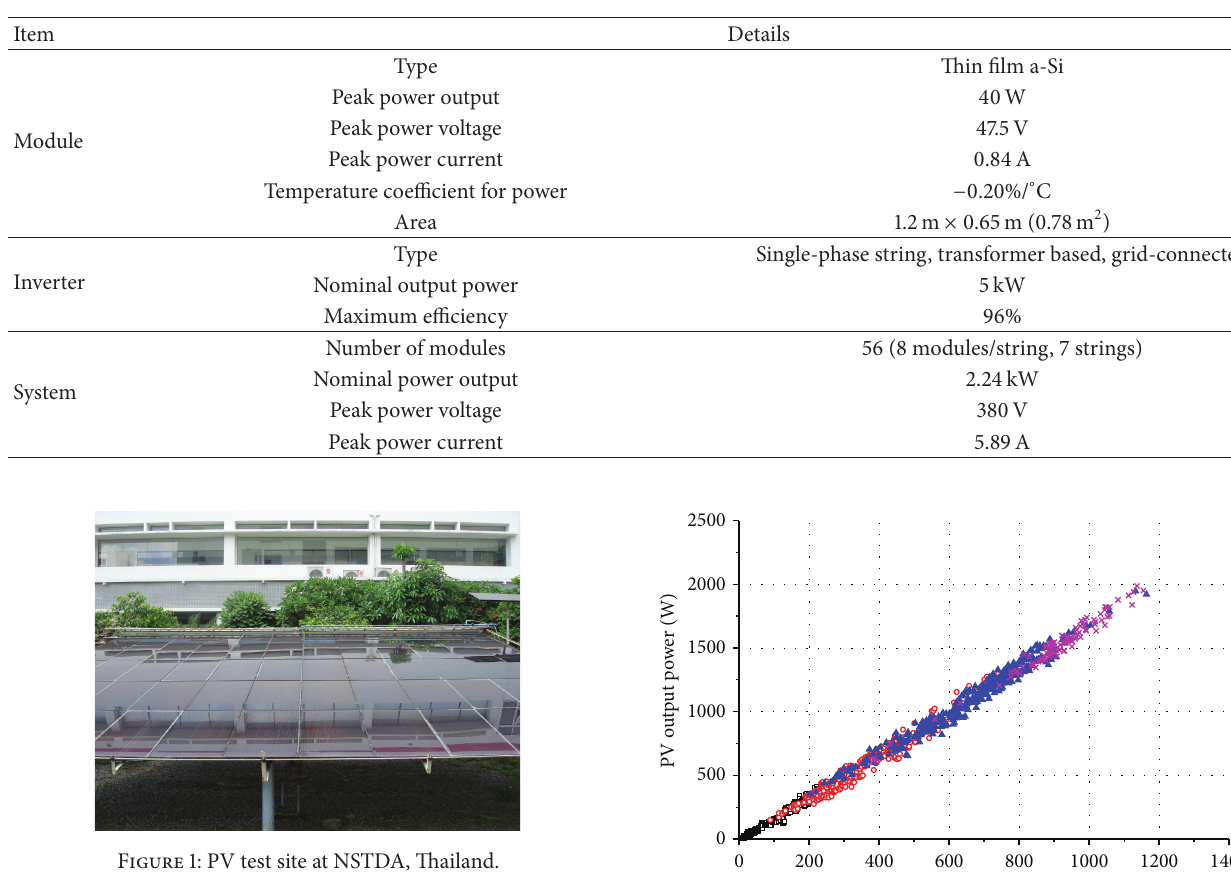
Table 1: PV module and system characteristics.